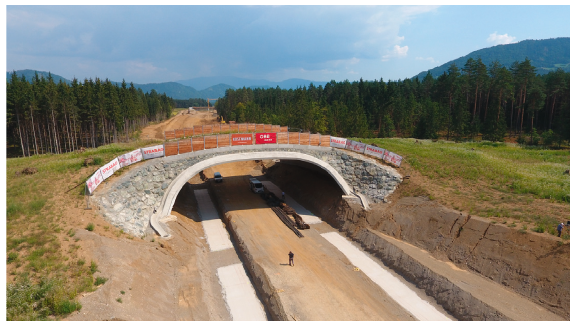
Figure 2: Shell bridge built in Carinthia in Austria with PFHC (plan dimensions: 36.2 × 38.7m, height: 8.1 m, and thickness: 0.45m).